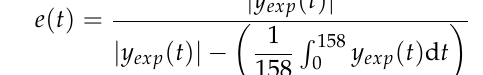
, y exp and u ( t ) B C